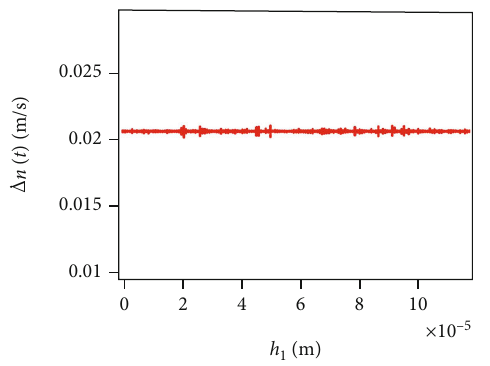
Figure 16: Bifurcation diagrams with changes in the wear when the misalignment in the x direction is 2 : 8 × 10 − 4